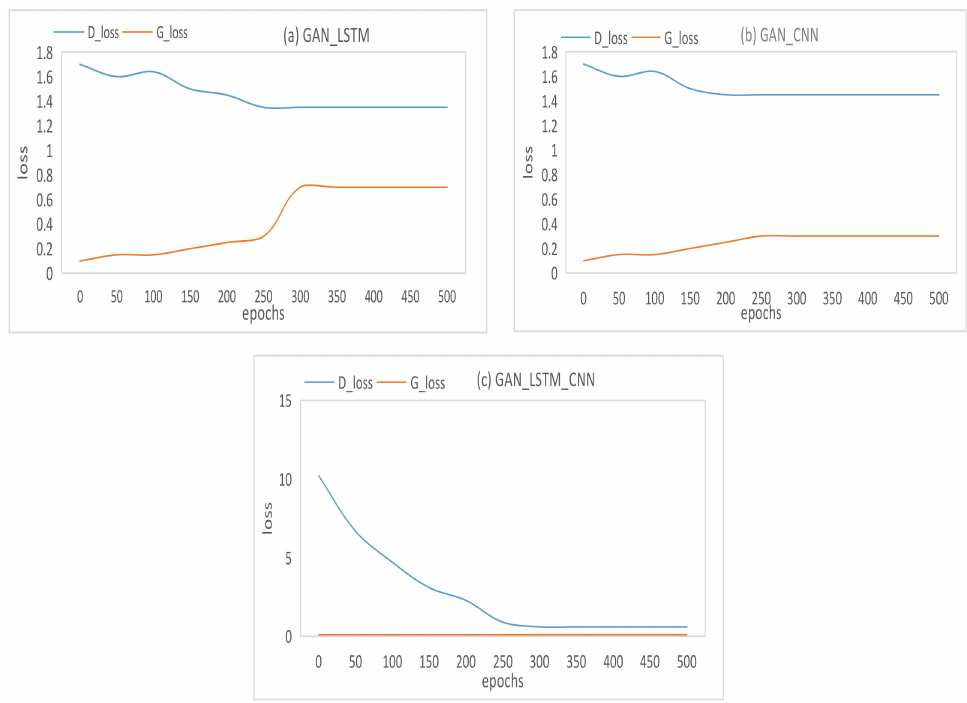
Figure 21. Training loss of the Generator(G_loss) and Discriminator(D_loss) of ( a ) GAN_LSTM, ( b ) GAN_CNN and ( c ) GAN_LSTM_CNN models. In GAN_LSTM and GAN_CNN, the loss of discriminator is higher than the loss of generator, and through the training process, both loss paths become flat. Compared with GAN_LSTM and GAN_CNN, the discriminator in GAN_LSTM_CNN learns better and